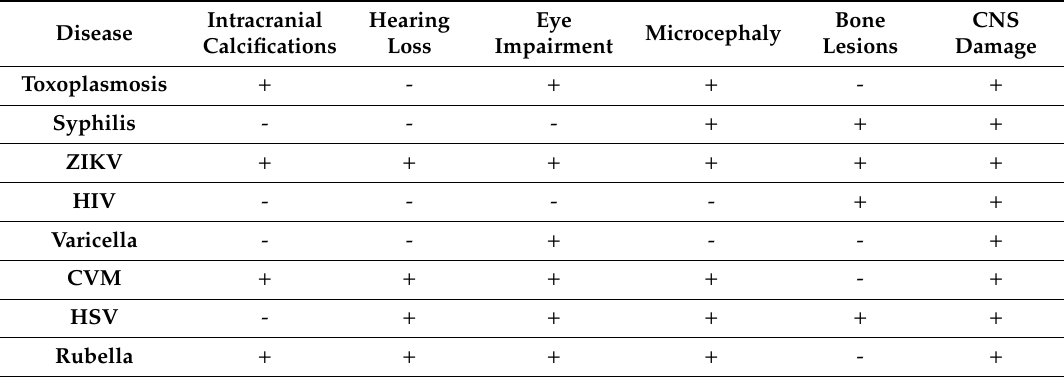
Table 1. Main symptoms identified in neonates exposed to congenital infections. The + sign means that the indicated symptom has already been related to the disease; while the sign - means that the symptom has little or no relation. Zika virus (ZIKV), human immunodeficiency virus (HIV), human cytomegalovirus (CVM), herpes simplex virus (HSV). Intracranial Disease